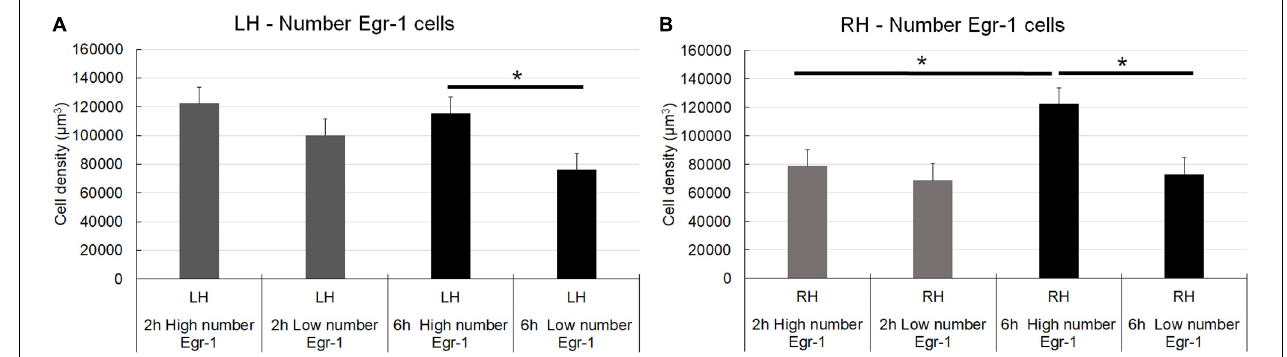
FIGURE 7 | Graphic representation of the density of Egr-1–positive cells in the somatosensorial cortex. The graphs show stereological estimates of Egr-1–positive cell density ( µ m 3 ; mean) in the infragranular layers of the somatosensorial cortex according to the indicated recording time (2 or 6 h) and according to the number of episodes of cortical spreading depression (high number and low number). (A) Left hemisphere; (B) Right hemisphere. Horizontal bars and ( ∗ ) indicate statistically indicate statistically significant differences using two-way analysis of variance, Holm-Sidak method; overall significance level, 0.05; 2 and 6 h, 2 and 6 h of recording; high and low number, high and low number of CSD episodes; sham, zero